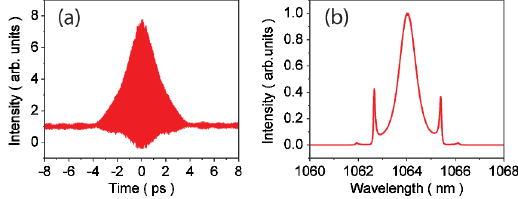
FIG. 2. The soliton laser characterization: (a) the second-order autocorrelation; (b) the